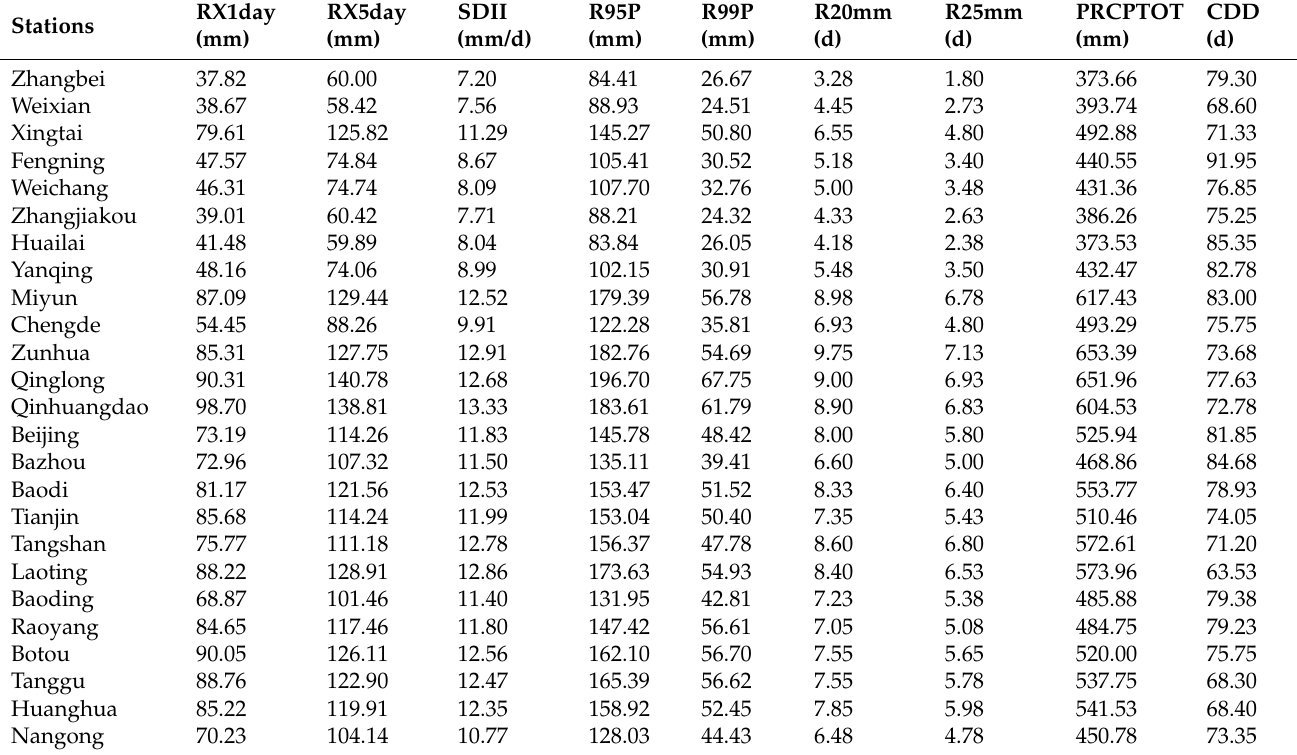
Table 2. Extreme precipitation indices at 25 meteorological stations in the Beijing–Tianjin–Hebei region from 1980 to